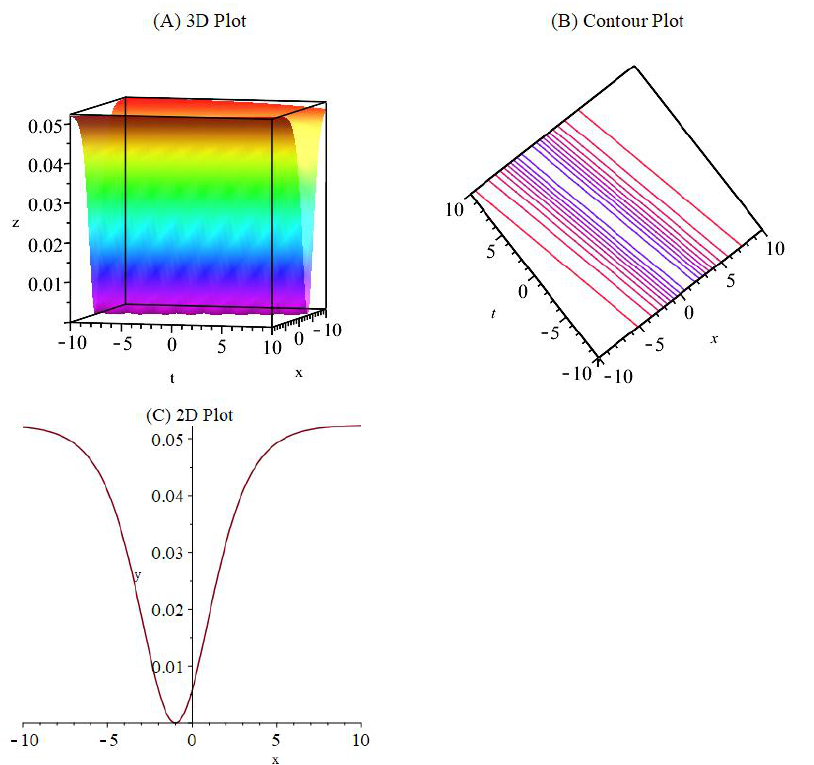
Figure 4. Two-dimensional and three-dimensional plots of the dark soliton solution | Equation ( 15 ) | for ε 1 = − 0.12, ε 2 = 0.55, ε 3 = − 1.2, ε 4 = 0.5, η 1 = 0.9, η 2 = 0.01, Γ = 2, a = 2, y =